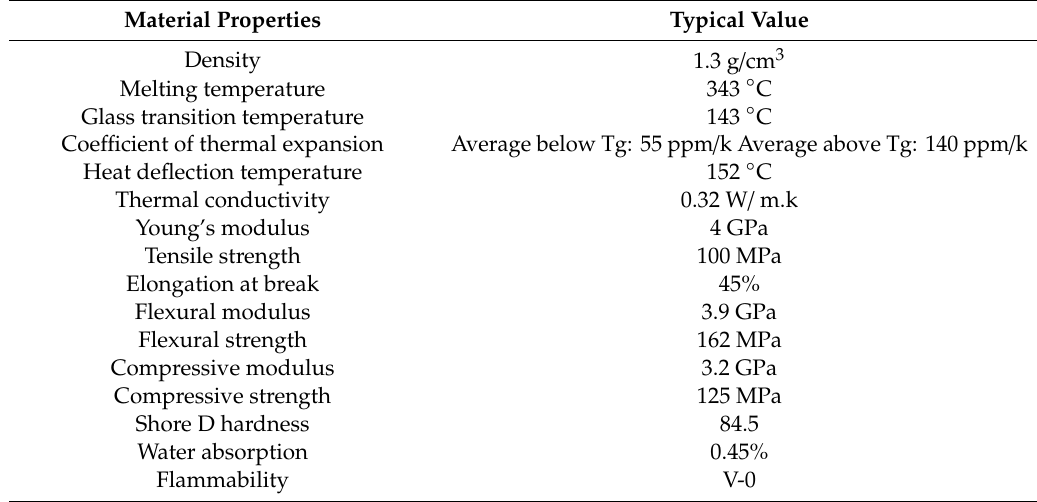
Table 1. Physical and mechanical properties of PEEK